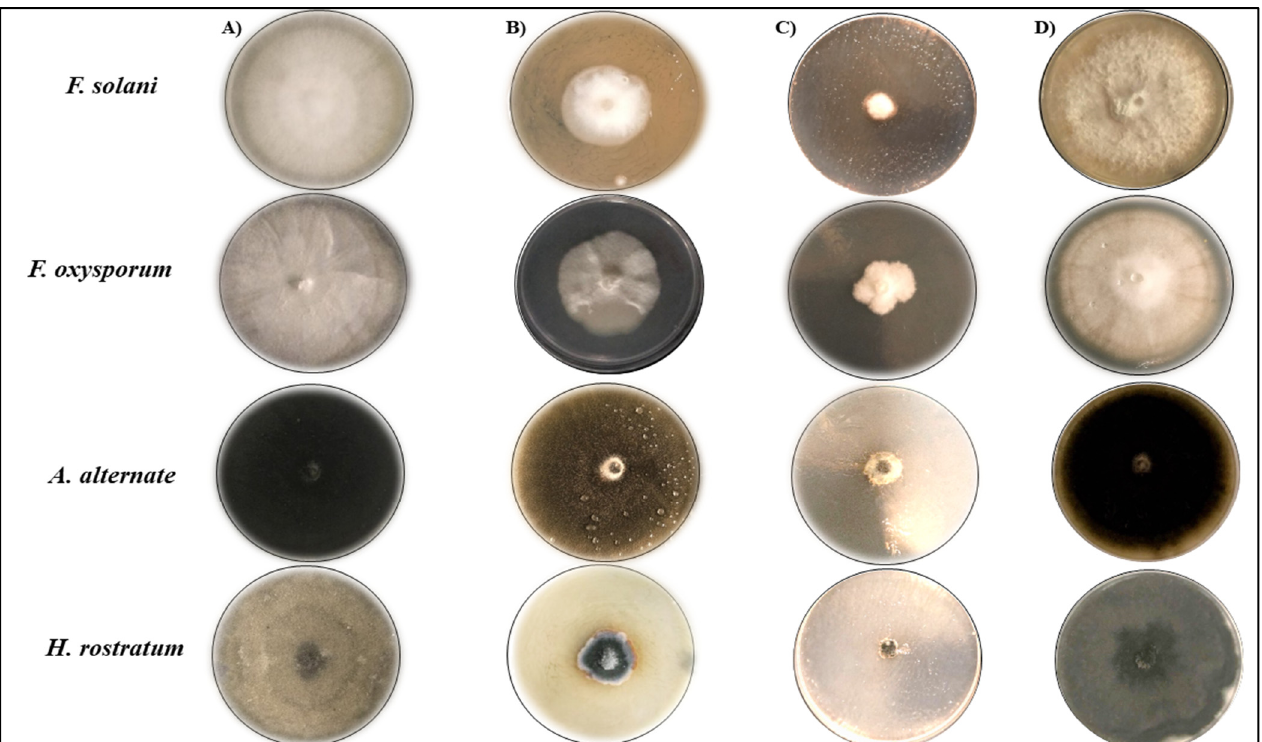
Figure 7. The antifungal activity of aqueous GSE and the biosynthesized GSE-AgNPs. The mycelial growth was measured by the agar well diffusion method using potato dextrose agar (PDA) media. The plates were treated with either ( A ) Milli-Q water as control, ( B ) GSE extract (100%), ( C ) 0.2 mL AgNO 3 , or ( D ) 0.2 mL GSE-AgNPs. The mycelial growth measuring of the colony diameter after seven days. The mycelial growth was measured by ImageJ at the scale of 2.61 pixels/mm.